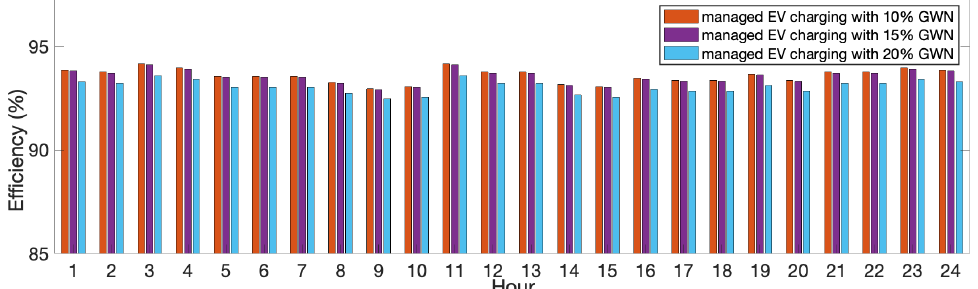
Figure 11. Comparison of distribution system efficiency of different scenarios with different percent- ages of